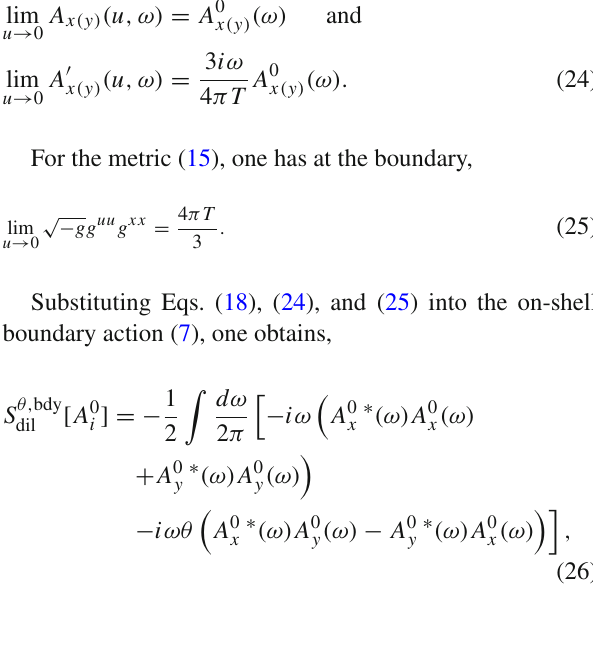
Fig. 4 Real and imaginary parts of the Hall AC conductivity as func- tions the θ -angle and the dimensionless frequency variable, w = 3 ω/ 4 π T , for C (cid:12) = (cid:12) L / 2 = 2 (dimensionless combination involv-